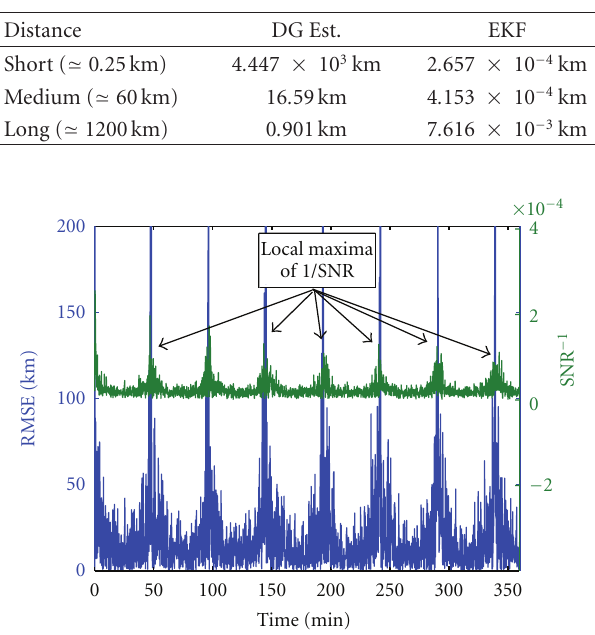
Figure 4: DG Est. Noise-to-Signal Ratio.